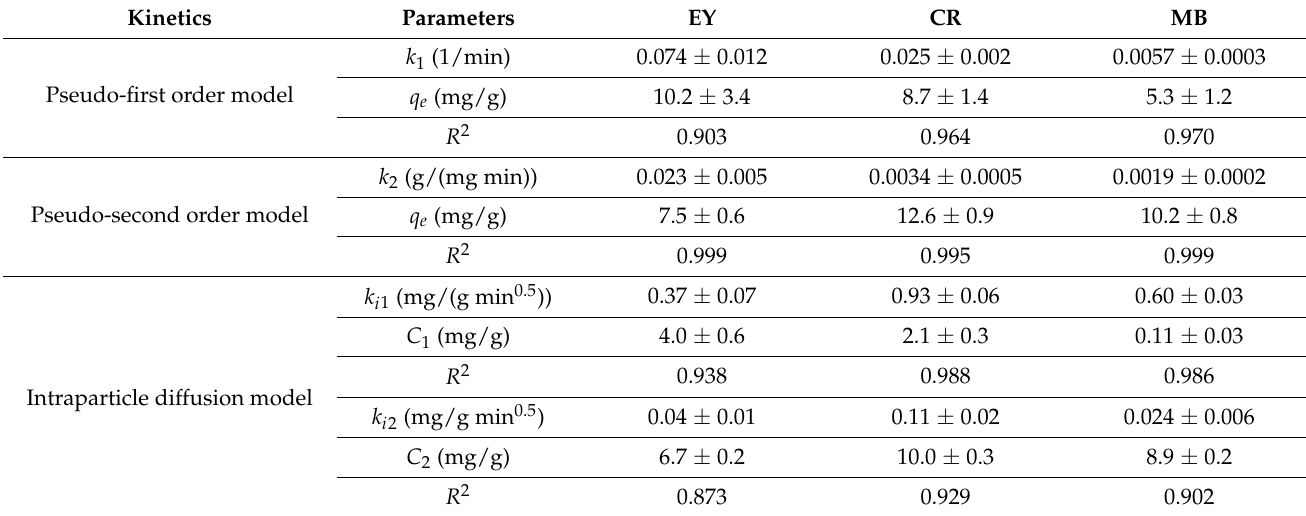
Figure 9. The pseudo-first-order ( a , c , e ) and pseudo-second-order ( b , d , f ) kinetics of EY ( a , b ), CR ( c , d ) and MB ( e , f ) adsorption on amino-functionalized Fe 3 O 4 @SiO 2 core-shell magnetic NPs at 25 ◦ C. Table 1. Kinetic parameters (Equations (2–4)) for the adsorption of the dyes (initial C 0 = 30 mg/L) on Fe 3 O 4 @SiO 2 -NH 2 NPs at 25 ° C.